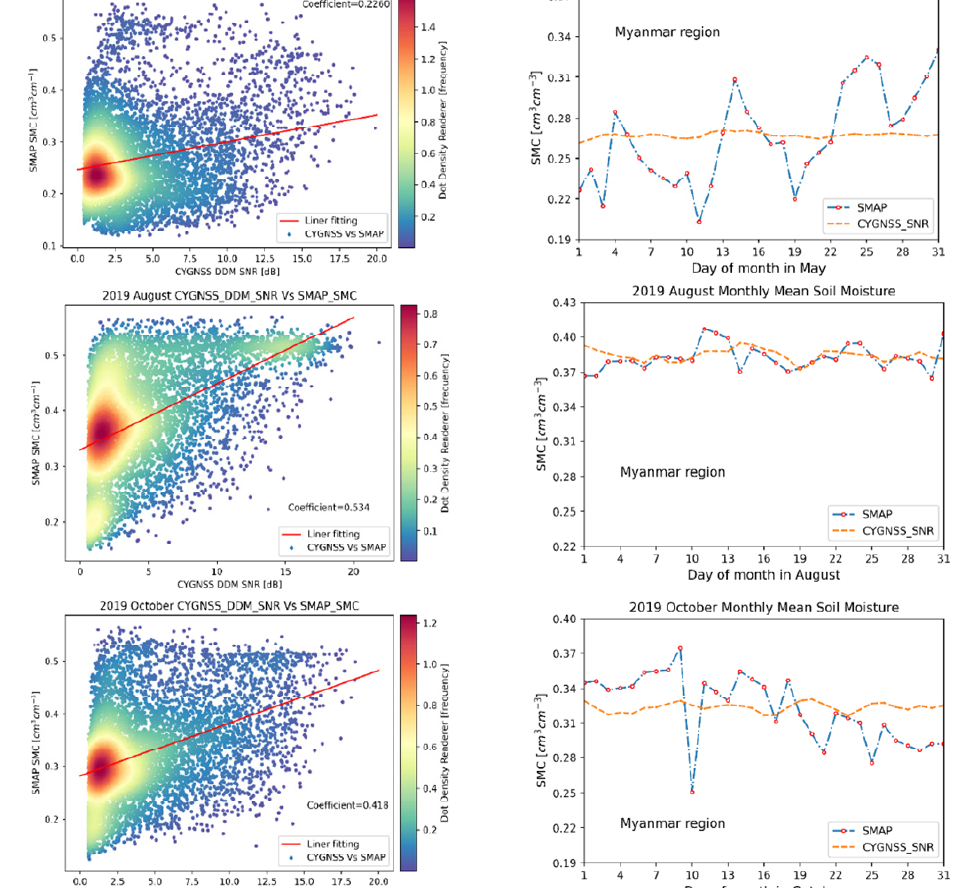
Figure 8. CYGNSS DDM and SMAP SM correlation and monthly mean soil moisture in May, August, and October 2019.